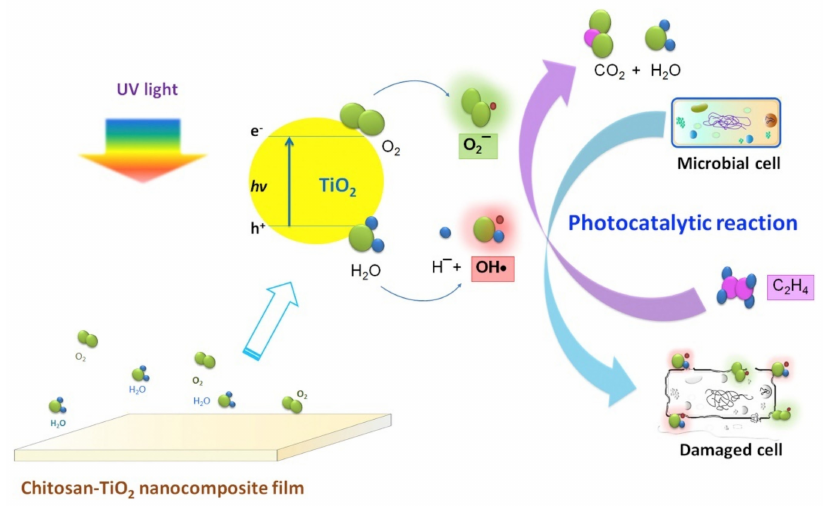
Figure 5. Schematic diagram of possible mechanism of photocatalytic degradation of ethylene and antimicrobial activity of CS—TiO 2 nanocomposite film [30]. When activated by ultraviolet (UV) light, electrons on TiO 2 surface are promoted and transferred from the valence band to conductance band. This produces electron–hole pairs in the valence band. The positive hole (h+) reacts with water or hydroxide ions (OH–) adsorbed on the TiO 2 surface to produce a highly reactive hydroxyl radical (OH). Electrons (e − ) reduce oxygen to produce superoxide ions (O 2 − ). These O 2 − and OH are strong reactive oxygen species (ROS), which further oxidize ethylene to carbon dioxide and water as end